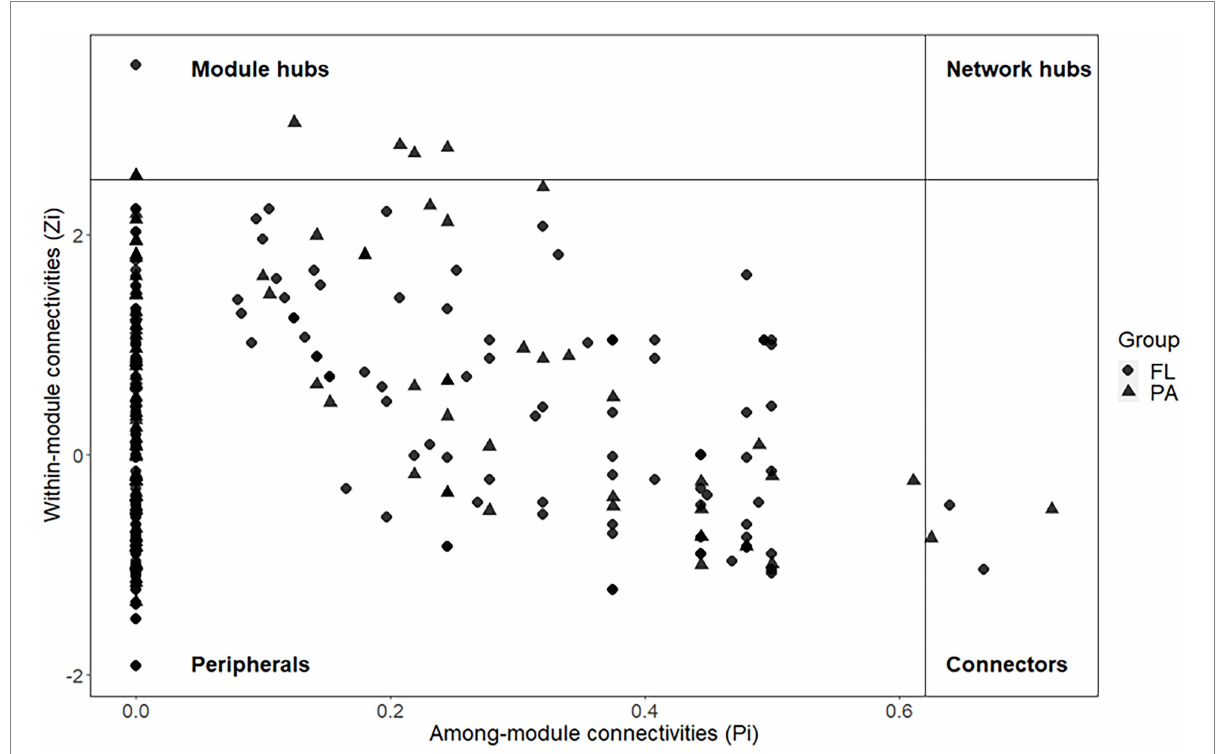
FIGURE 3 Z-P plot showing the distribution of OTUs based on their topological features in FL and PA bacterial communities.